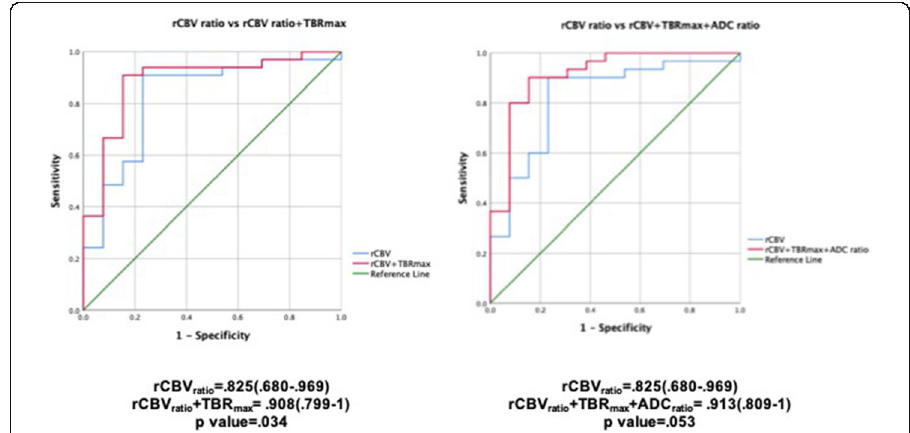
Fig. 4 ROC curves for relative CBV and TBR max combined compared to relative CBV alone is shown on the left. The graph on the right shows the ROC curve for relative CBV with TBR max and ADC ratio compared to relative CBV alone. The area under curve for rCBV and TBR max taken together increased to 0.908 compared to 0.825 for rCBV alone with statistically significant difference. The area further increased to 0.913